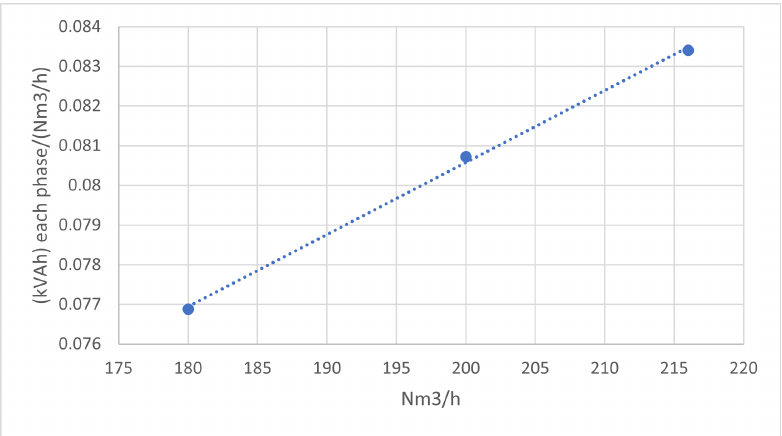
Figure 9. Energy consumption required to generate a unit of flux (about 1 Nm 3 /h) of ATEKO-air depends on the outlet flux level produced by the